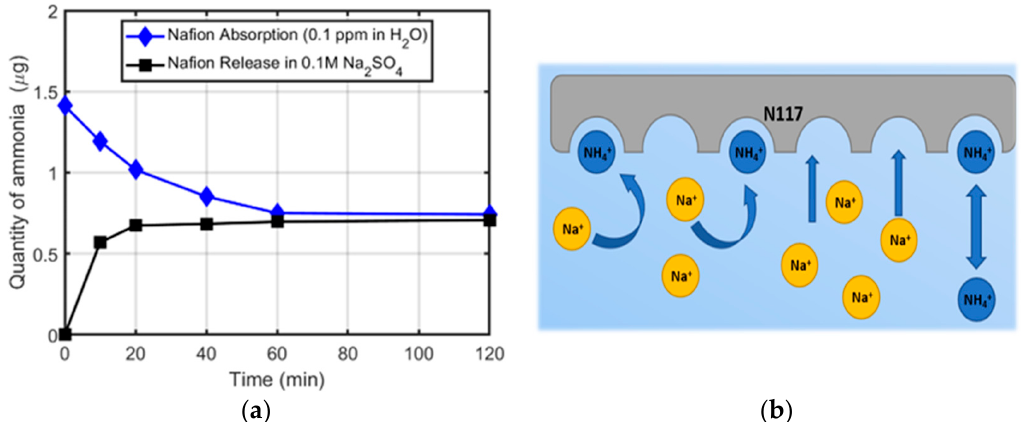
Figure 3. Ammonia quantity as a function of time: ( a ) in NH 4 Cl water solution with N117 (black squares), and in 0.1 M Na 2 SO 4 solution with N117 loaded with ammonia (blue circles); ( b ) simplified scheme of the interactions between ions in solution and N117 membranes in the case of a 0.1 M Na 2 SO 4 solution.